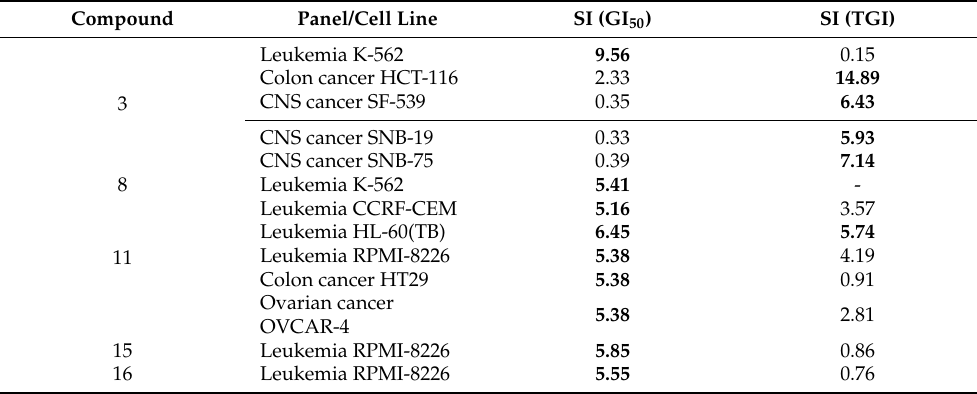
Bold values represent best